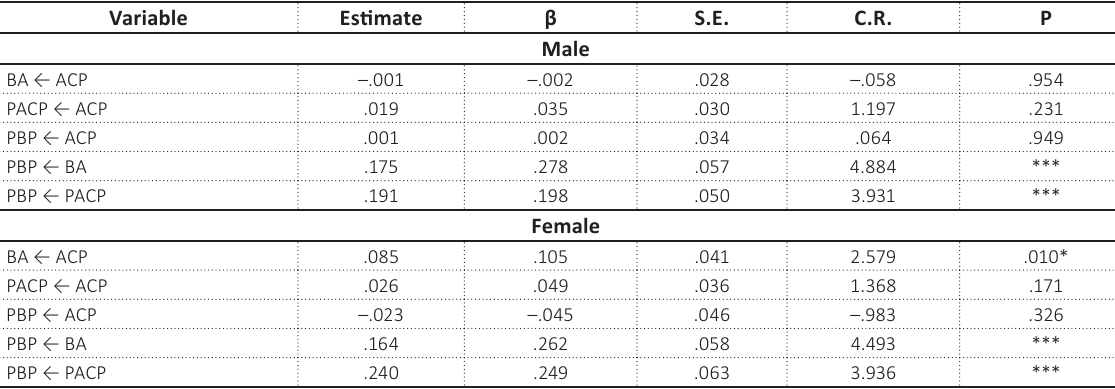
Table 6. Gender regression weights Variable